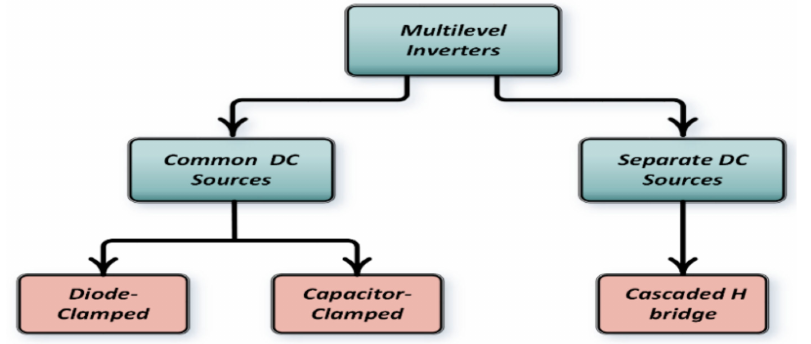
Figure 30. Classification of multilevel inverters [119].